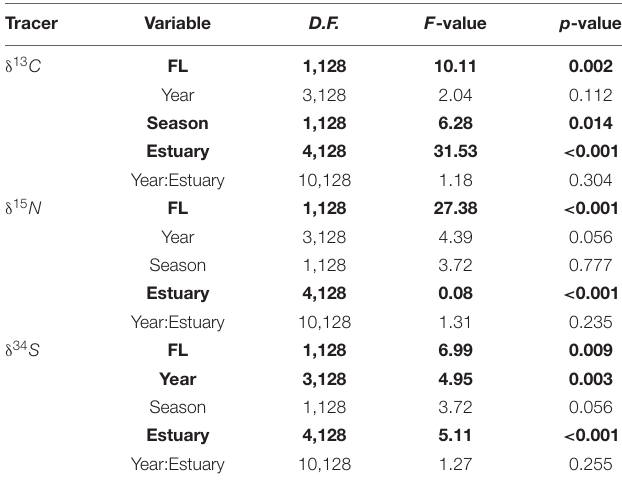
TABLE 3 | Model results showing main effects of shark size (FL), capture year (Year), capture season (Season), capture location (Estuary), and interactive effect of Year:Estuary on stable isotope values obtained from juvenile bull shark muscle